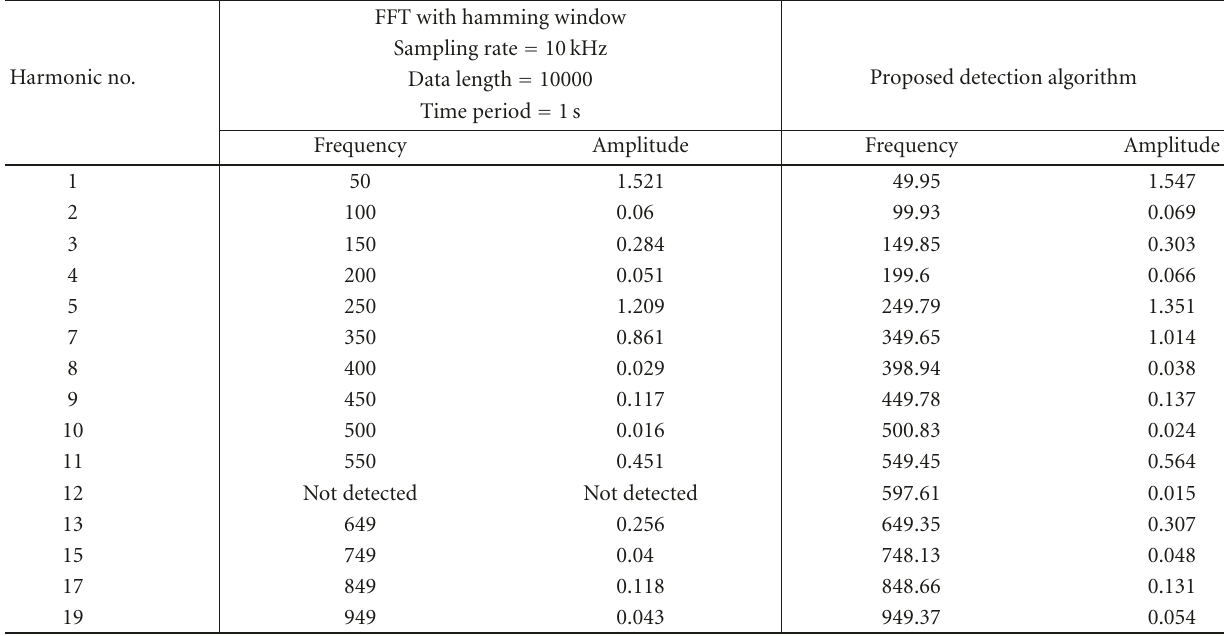
Table 8: Experimental results.